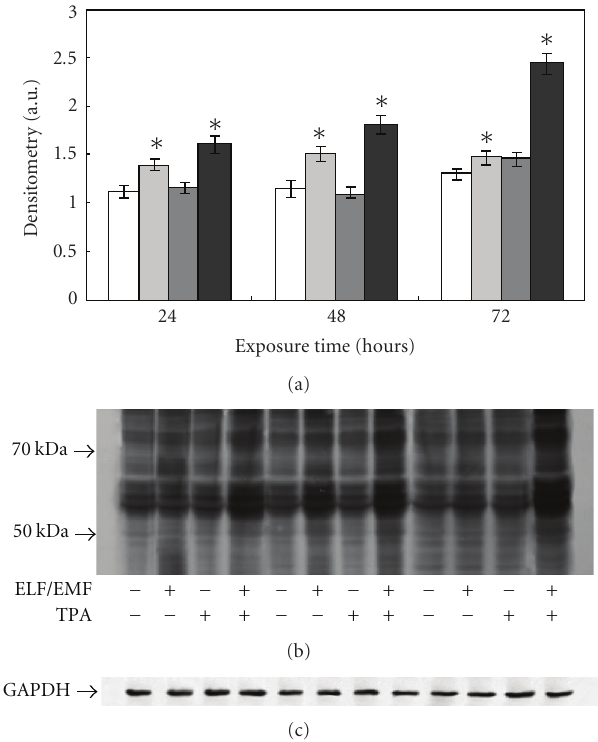
Figure 3: E ff ect of ELF-EMFs exposure and TPA treatment on protein oxidation. Protein oxidation was analysed and quantified by measuring the amount of protein carbonyl groups. The densit- ometric analysis from six separate blots provided for quantitative analysis of the amount of protein carbonyls is present (a) and a representative Western blot of protein carbonyls is shown (b). Equal protein loading was verified by using an antibody directed against GAPDH (c). Caco cells were cultured with and without 0.1 μ M TPA and exposed to ELM-EMFs for 24, 48, and 72 hours. After harvesting and lysing the cells, samples were treated according to the OxyBlot procedure (Oxidized Protein Detection Kit, Oncor). Carbonyl groups were revealed by appropriate antibodies using an Enhanced Chemiluminescence Western blotting analysis system. Data points marked with an asterisk are statistically significant compared to their respective not exposed control cells ( P < .